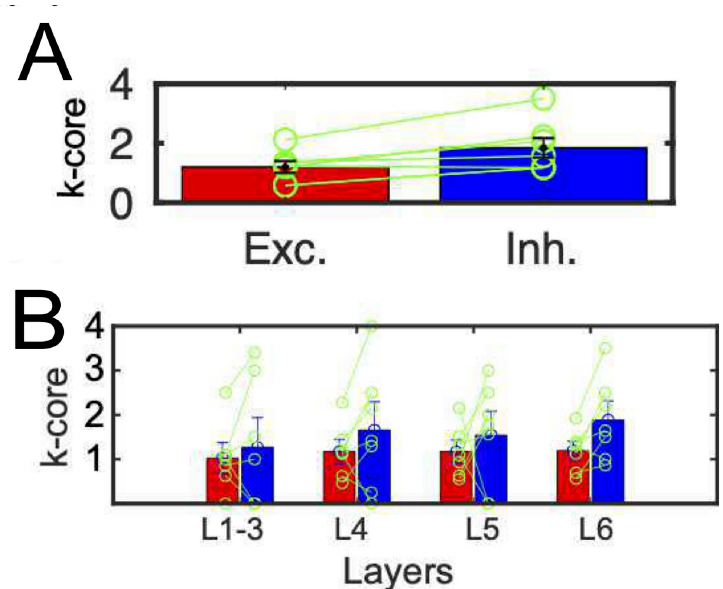
Fig 6. E/I cell categories and k-core centralities: A shows the difference of averaged k-core values for all excitatory and inhibitory neurons. The error bars and circles correspond with the variety among 7 cortical slices. They showed significant differences (p < 0.05, Wilcoxon signed rank test, means and variances of k-core centrality for excitatory neurons and inhibitory neurons: 1.20 ± 0.27 vs. 1.87 ± 0.72; Z (7 slices) = 2.45). This trend was also observed even for only connected components. B shows the difference of averaged k-core values for excitatory and inhibitory neurons within individual layers. The left and right bars for individual layers correspond with excitatory and inhibitory neurons respectively. We performed a non-parametric paired statistical test between excitatory neurons and inhibitory neurons separately for different layers, and shown as � mark if significant difference existed (p < 0.05, Wilcoxon signed rank test; layer1-3: 1.02 ± 0.49 (excitatory) vs. 1.27 ± 1.78 (inhibitory); Z(7 slices) = 0.36, p = 0.34; layer4: excitatory, 1.17 ± 0.30 vs. inhibitory, 1.66 ± 1.62; Z(7 slices) = 0.79, p = 0.15; layer5: excitatory, 1.17 ± 0.26 vs. inhibitory, 1.54 ± 1.15; Z(7 slices) = 0.86, p = 0.29; layer6: excitatory, 1.18 ± 0.18 vs. inhibitory, 1.87 ± 0.64; Z (7 slices) = 2.8, p = 0.04). All error- bars in panels A and B express standard errors.